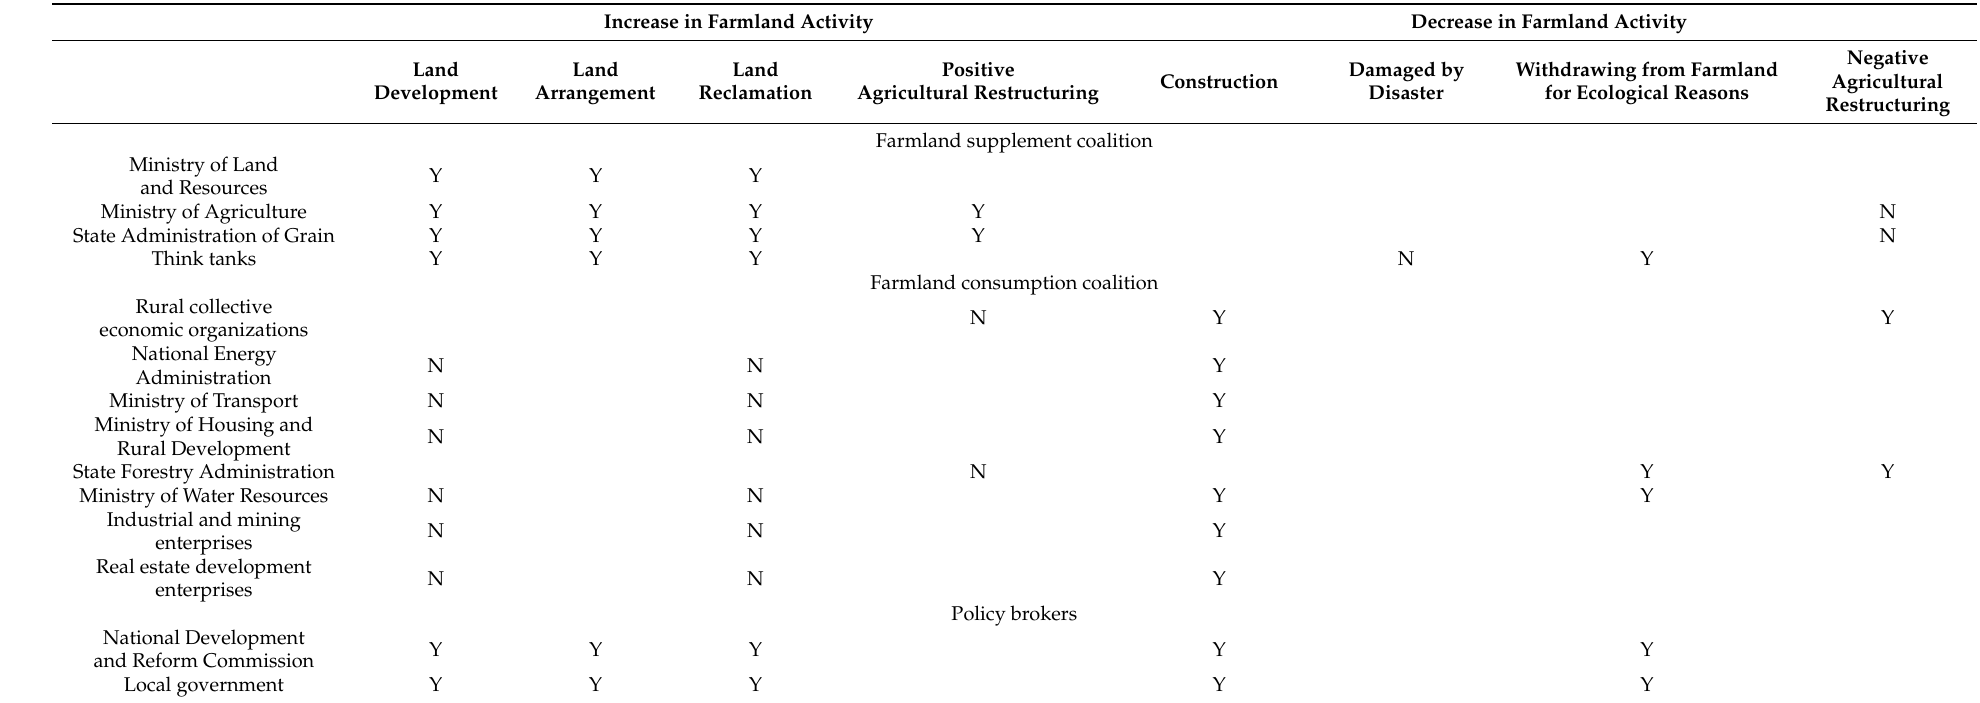
Table 2. Advocacy coalitions in the farmland transition policy